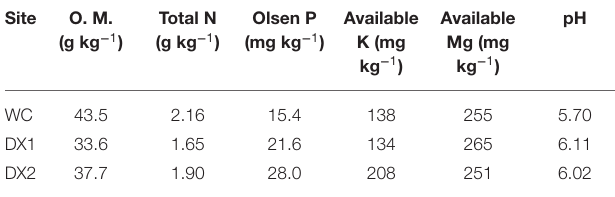
TABLE 1 | Soil chemical fertility properties.